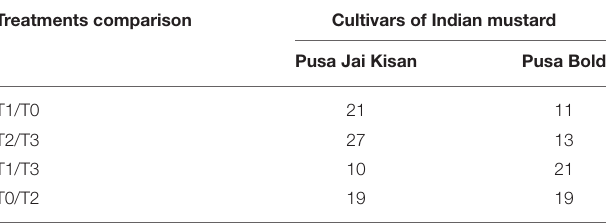
TABLE 1 | Differential expression of protein spots in Pusa Jai Kisan (N-inefficient) and Pusa Bold (N-efficient) cultivars of Indian mustard under the treatments of low-N, sufficient-N, ambient CO 2 , and elevated CO 2